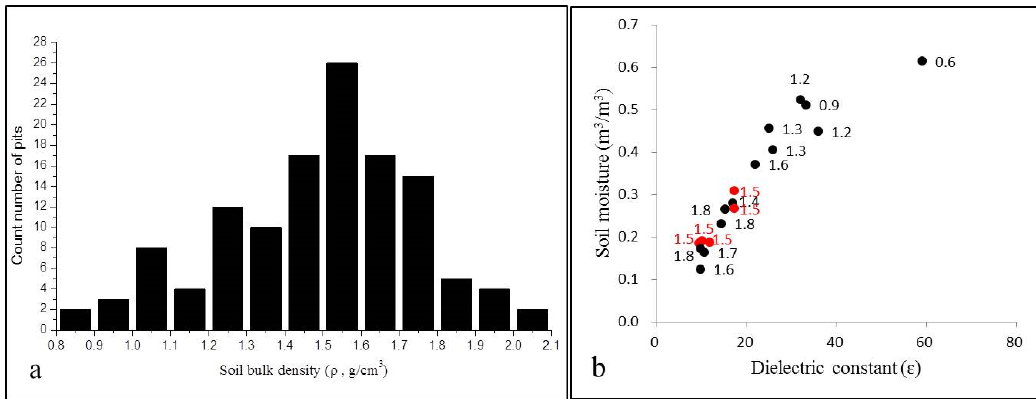
Figure 13. (a) Statistical histogram of the active-layer soil density variation on the Qinghai–Tibet plateau. (b) Scatter diagram of the relationship between the soil dielectric constant and moisture under different soil bulk densities.